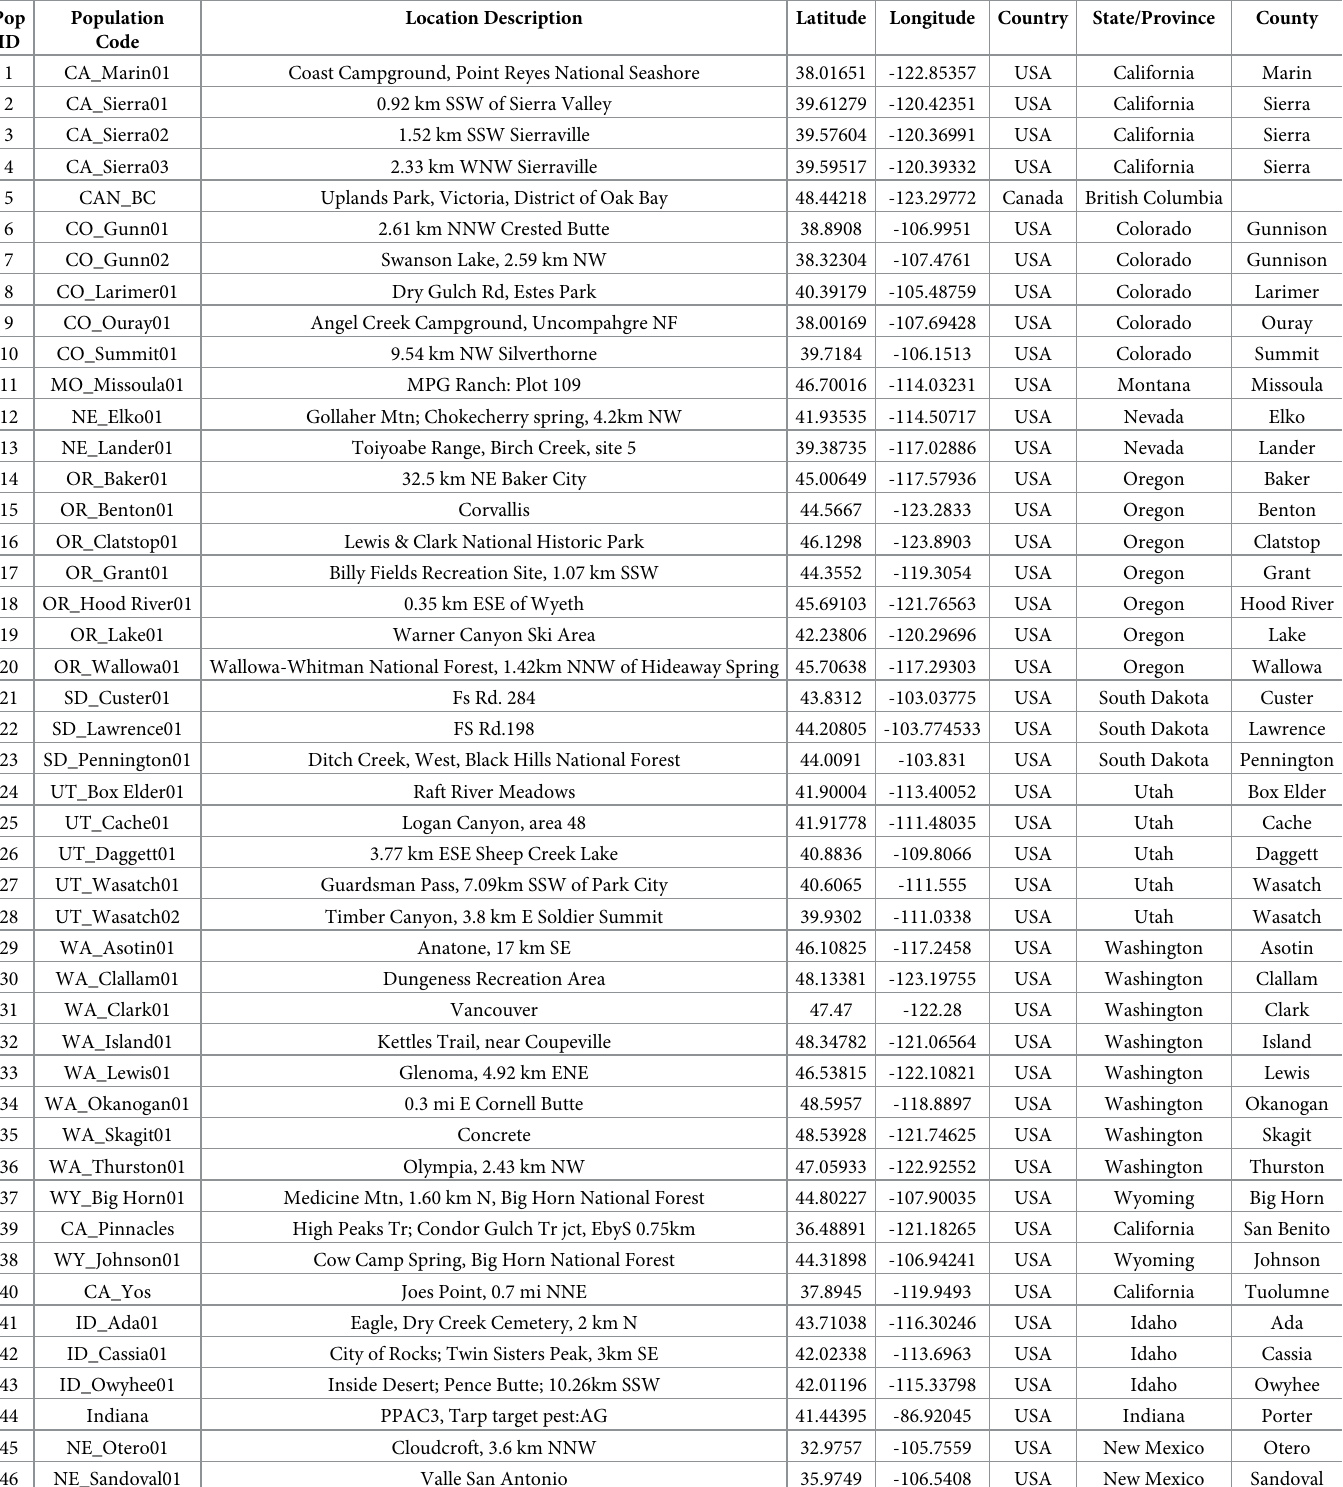
Table 1. Survey locations of populations in the Bombus fervidus species complex in North